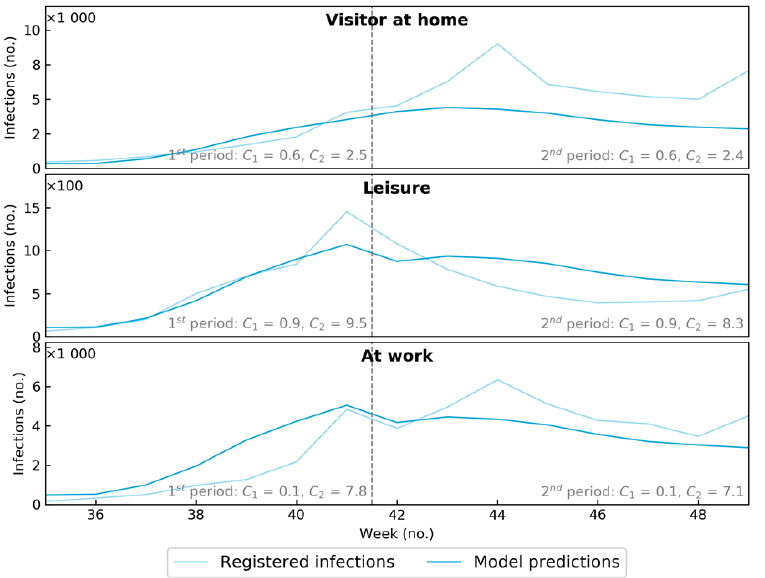
Figure 1. The number of infections based on internal validation by reproduction of infections at work, visitors at home, and at leisure.